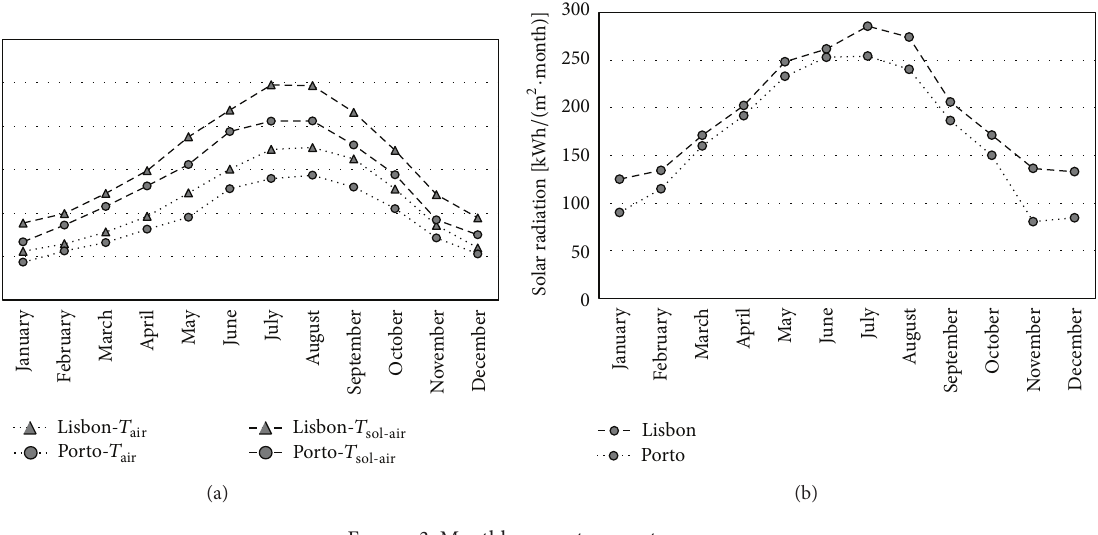
Figure 3: Monthly mean temperature.